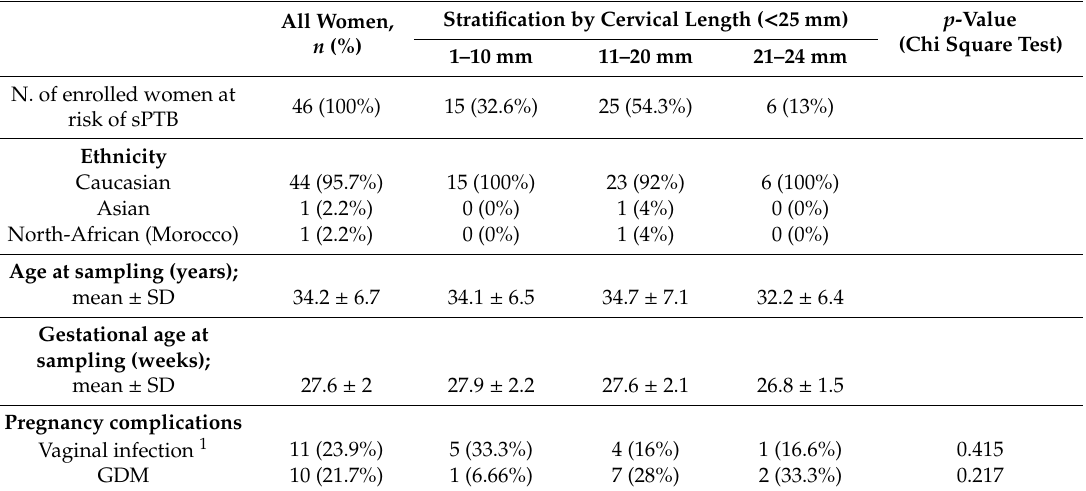
Table 1. Patient demographic and clinical